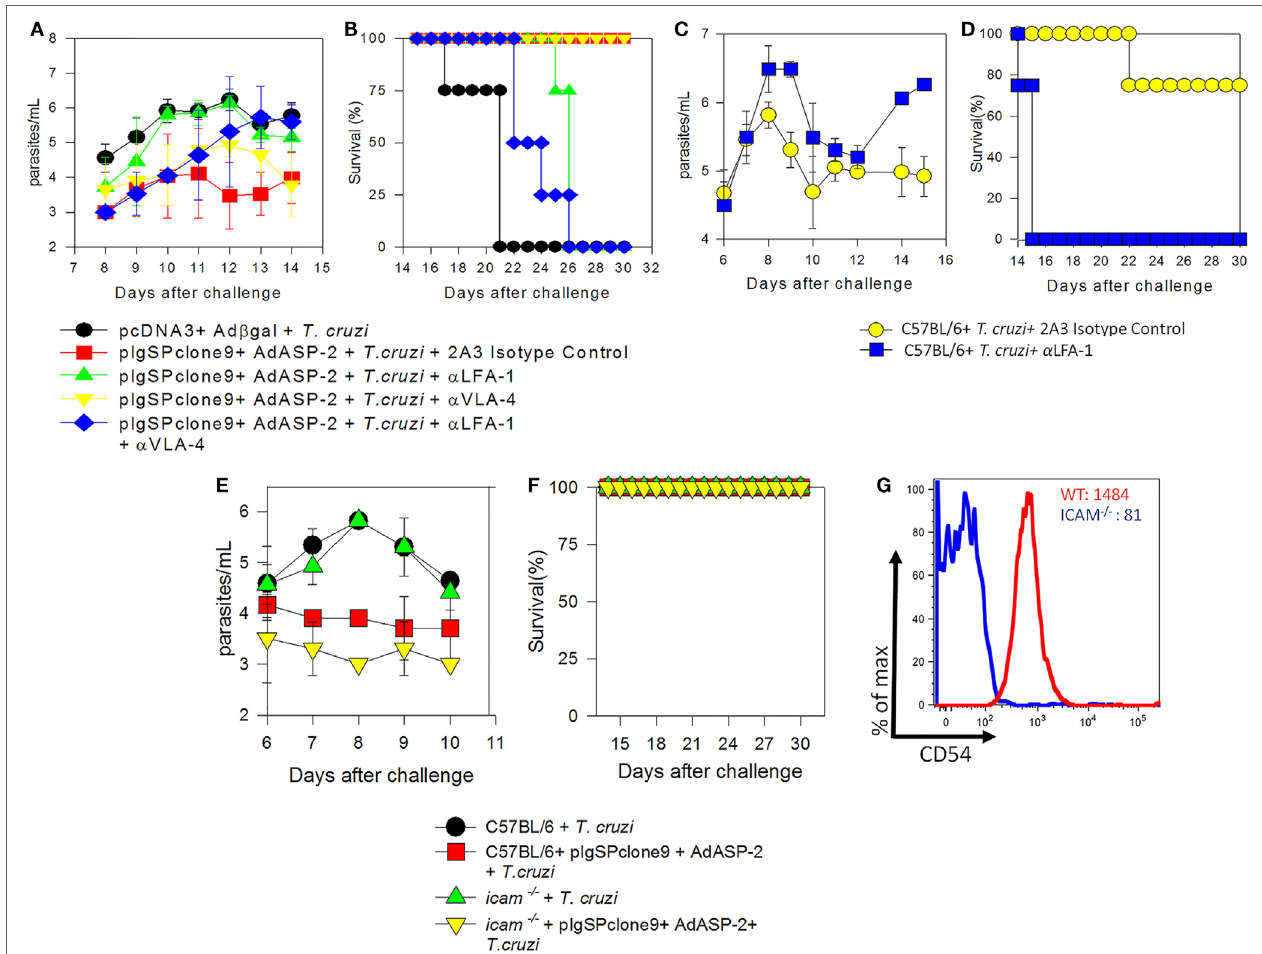
FigUre 1 | LFA-1 blockade increases blood parasitemia and culminates in the death of A/Sn and C57BL/6 mice. A/Sn-, C57BL/6-, and intercellular adhesion molecule (ICAM)-deficient mice were immunized with plasmids pcDNA3 and/or pIgSPclone9 and adenoviral vectors Ad β gal and AdASP-2. Fifteen days after the last immunization dose, mice were infected with 150 (A/Sn) and/or 10 4 (C57BL/6 and ICAM mice) blood trypomastigotes of the Y strain of Trypanosoma cruzi . Anti-VLA-4 and/or LFA-1 treatment was performed every 48 h after infection until the 20th days after infection. (a) Blood parasitemia was assessed, and values were log transformed and parasitemia data for each mice group are represented as mean ± SD for each group ( n = 4). Values from peak parasitemia (day 12) were compared by one-way ANOVA and Tukey’s HSD tests, and the results were as follows: Significant differences were found between the red in green groups ( P < 0.05). There were no significant differences between the blue group and the green group ( P > 0.05). (B) Kaplan–Meier curves for survival of the different groups were compared using the log-rank test. The results of the comparisons were as follows: The mice in red group survived longer than the mice in green group. The survival rate of mice in the blue group was similar to the mice in the green group. (c) Log parasitemia data for each mice group (C57BL/6 mice infected and/or treated with anti-LFA-1) are represented as mean ± SD for each group ( n = 4). Values from peak parasitemia (day 9) were no significantly different across the groups ( P > 0.05). On day 14, significant difference was found between the infected and treated with anti-LFA-1 mice and infected and treated with the anti-2A3 isotype control mice ( P < 0.05). (D) Kaplan–Meier curves for survival of the different groups were compared using the log-rank test. The results of the comparisons were as follows: the mice in yellow group survived longer than the mice in blue group. (e) Log parasitemia data for each mice group (ICAM-deficient and C57BL/6 mice) are represented as mean ± SD for each group ( n = 4). Peak parasitemia values (day 9) were significantly different across C57BL/6 groups and in ICAM-deficient mice groups ( P > 0.05). (F) Kaplan–Meier curves for survival of the different groups were compared, and there were no differences across groups. (g) MFI of CD54 (ICAM-1) on CD8 + T cells from C57BL/6 and ICAM-deficient mice: the red line indicates MFI of naïve C57BL/6 mice, whereas the blue line indicates MFI of naïve ICAM-deficient mice. One out of two individual experiments is